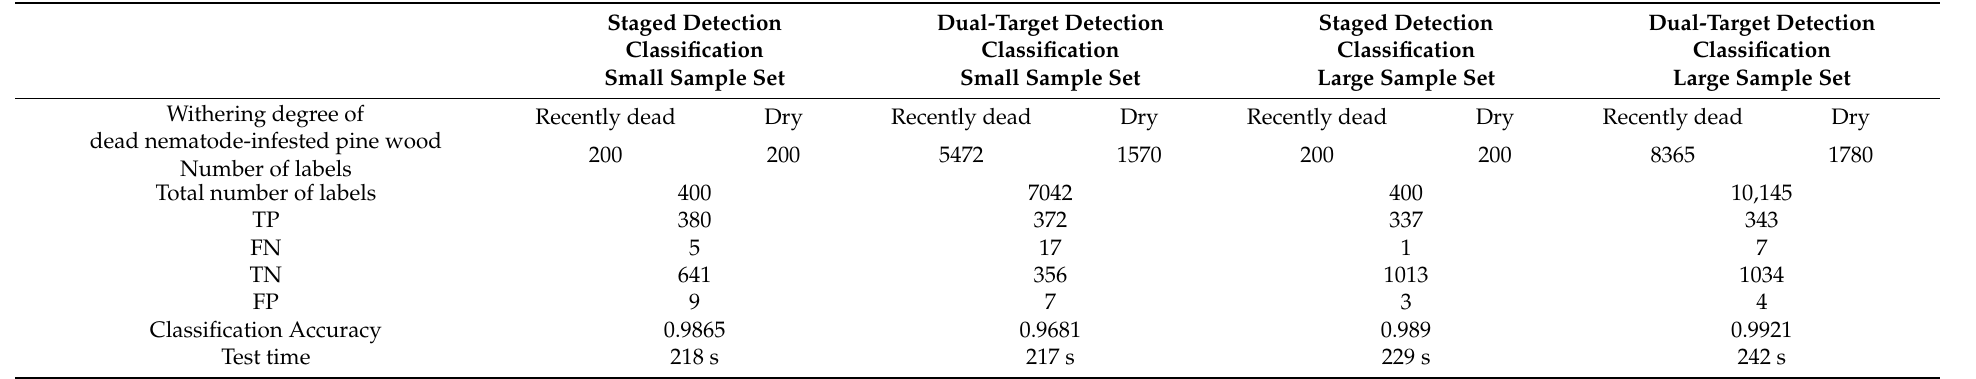
Table 8. Comparison of classification effects between classification by staged detection classification by dual-target detection